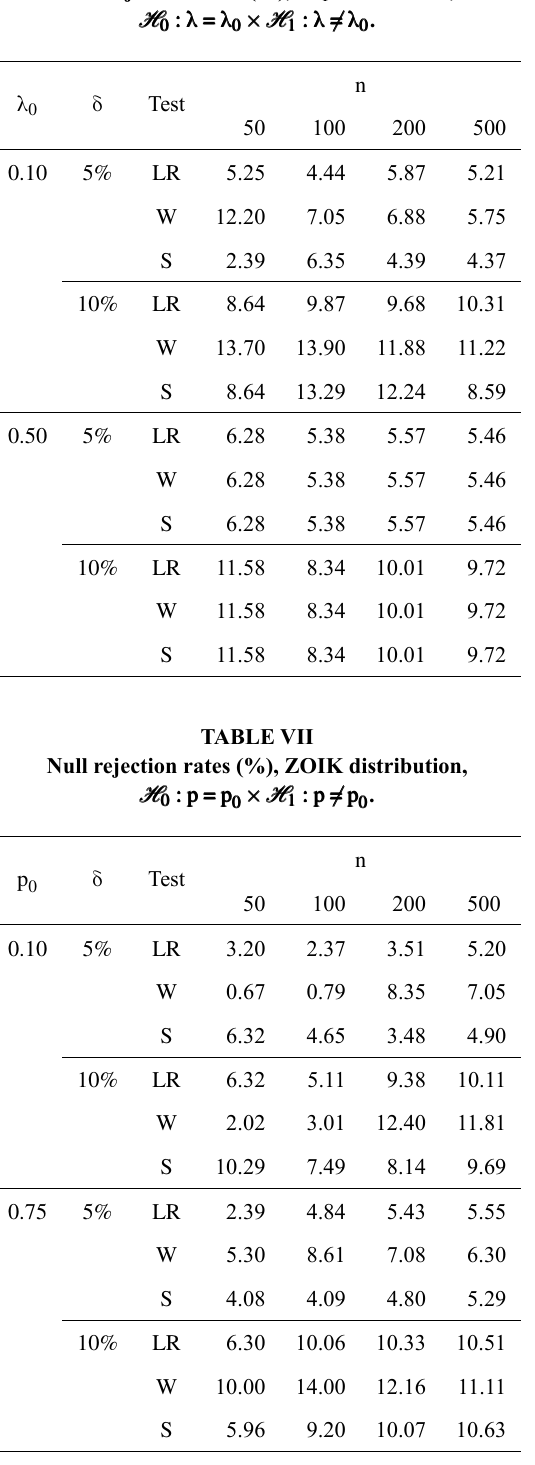
Null rejection rates (%), ZOIK distribution, H